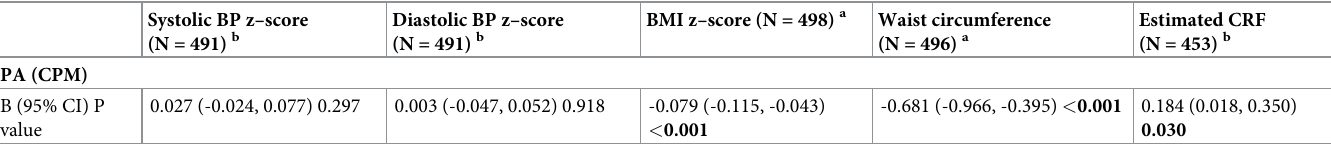
Table 3. Associations between total PA (CPM) and cardiovascular risk factors.